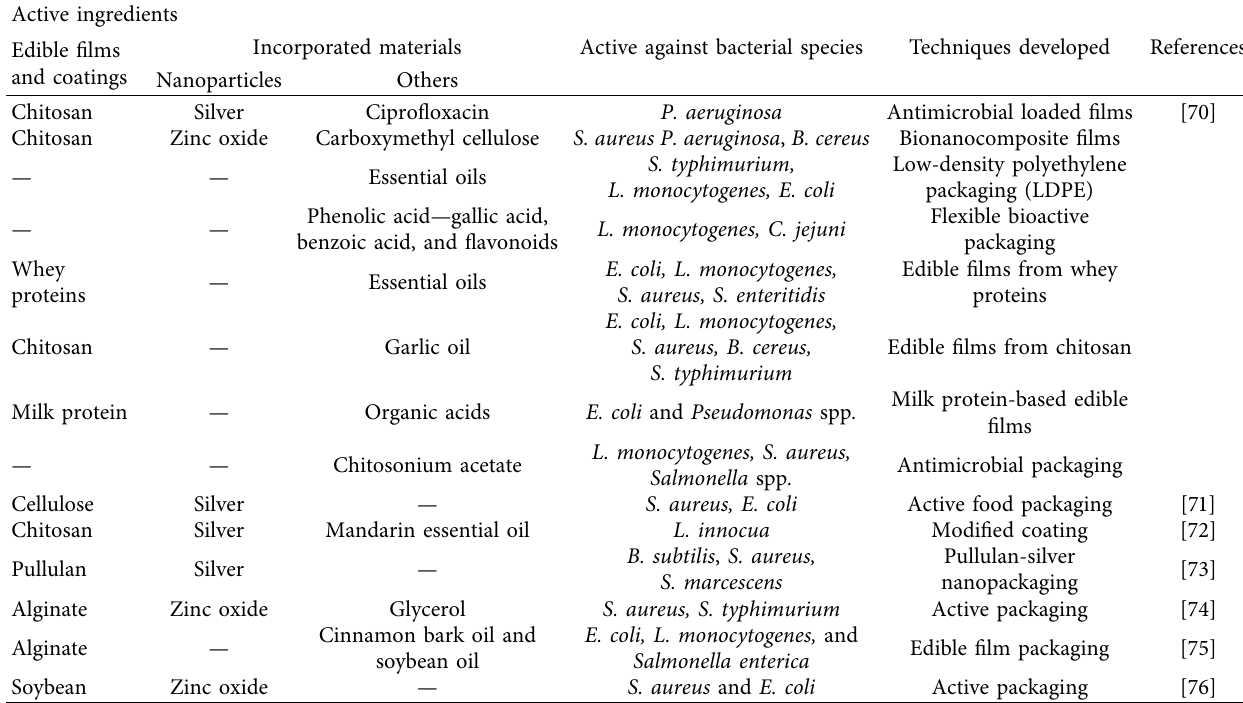
Table 3: Antimicrobial active